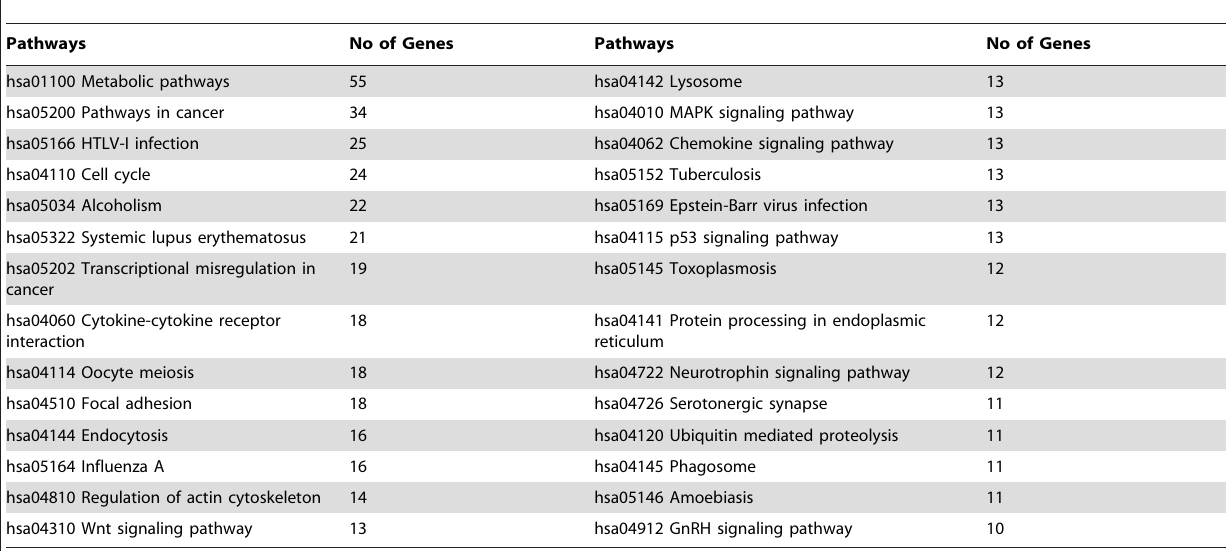
Table 2. Pathways differentially expressed upon areca nut treatment on HaCaT cells as revealed by KEGG pathway analysis.